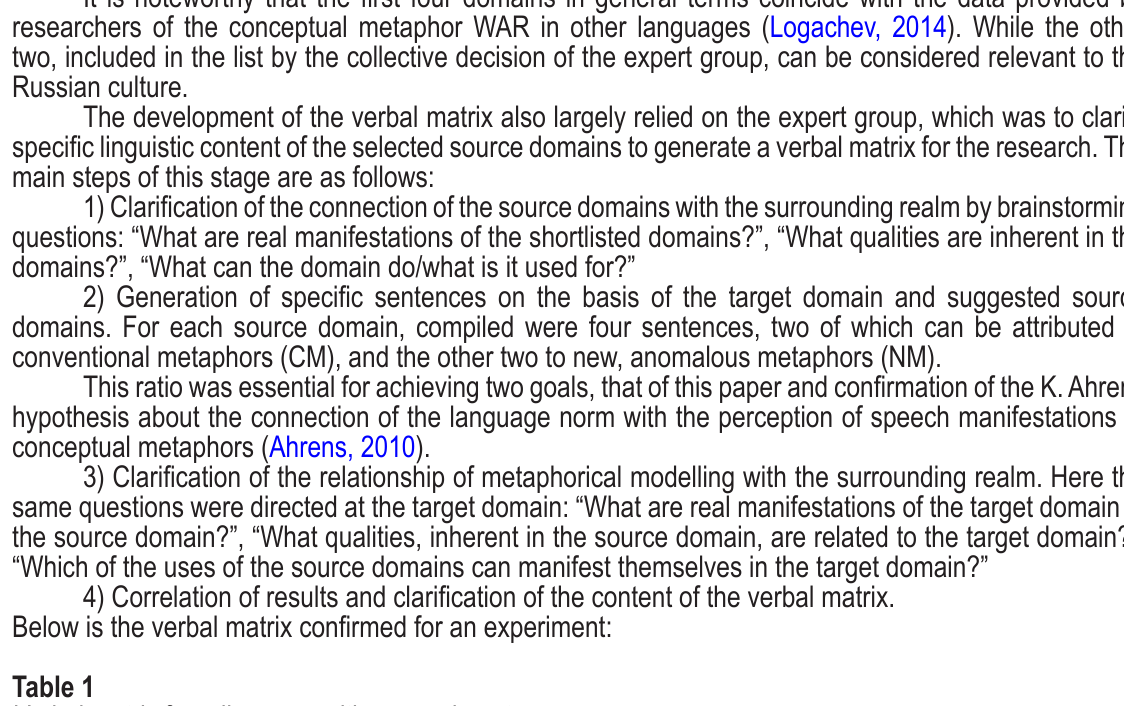
Verbal matrix for a linguocognitive